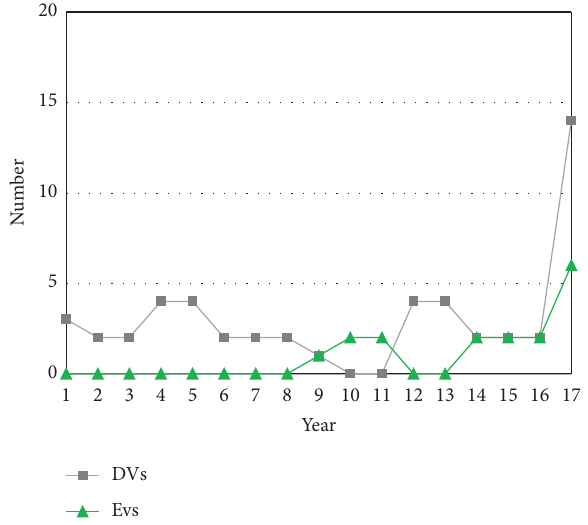
Figure 4: Number of salvaged vehicles during the planning